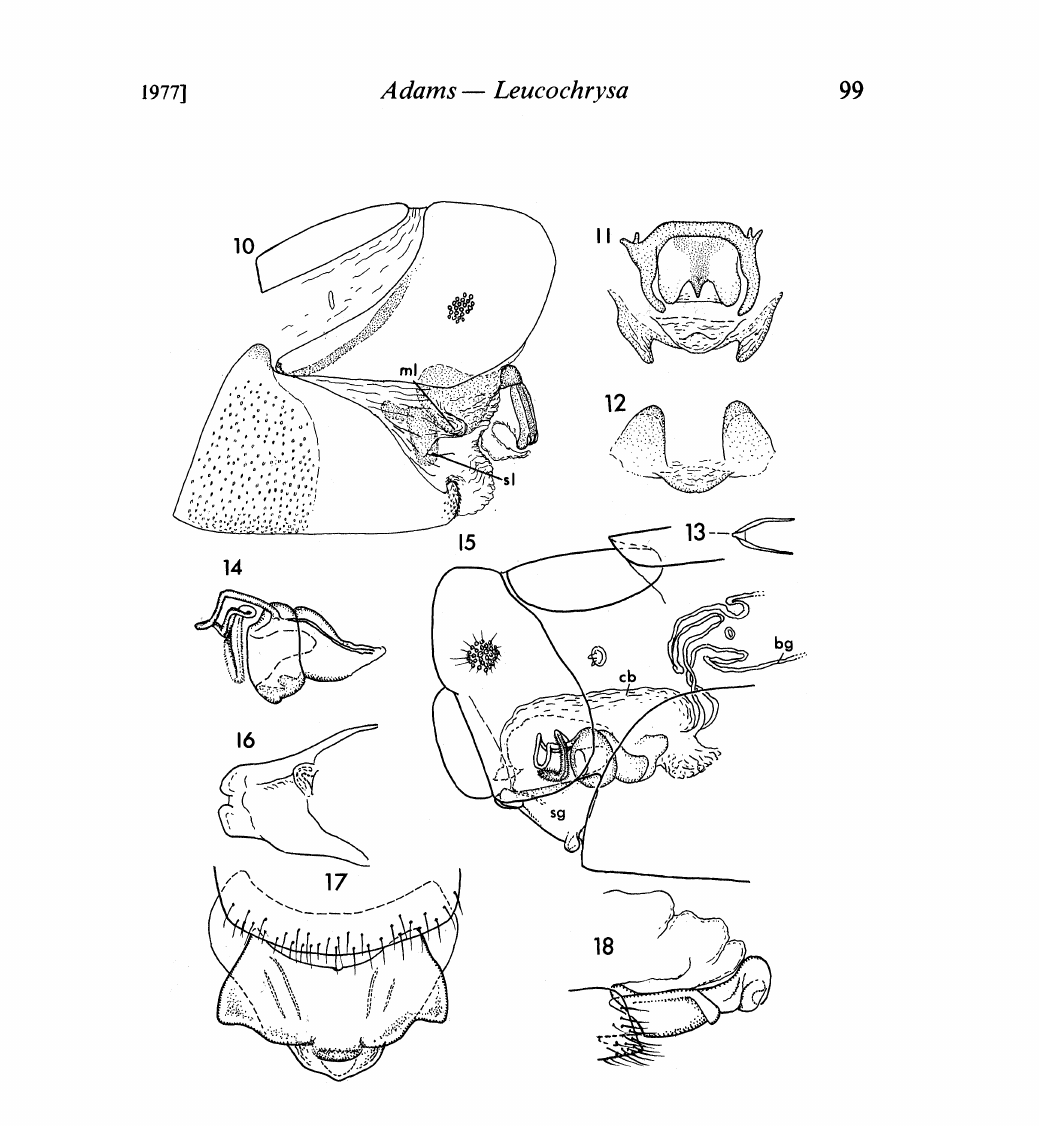
Figures 10-16. L. insularis. Fig. 10, male abdomen, lateral, sclerotized lobes withdrawn. Fig. 11, gonarcus, mediuncus and sclerotized lobes, dorsal view. Fig. 13, hypandrium internum. Fig. 14, spermatheca, dorsolateral. Fig. 15, female ab- domen, showing broadly sclerotized subgenitale, and internal structures. Fig. 16, subgenitale, ventral view. Figures 17-18, L. arizonica. Fig. 17, apex of seventh sternite and subgenitale, ventral. Fig. 18, same, lateral. Abbreviations used in Figs. 10-16: bc copulatory bursa, bg--bursal glands, ms menabranous sac, sg subgenitale, sl sclerotized